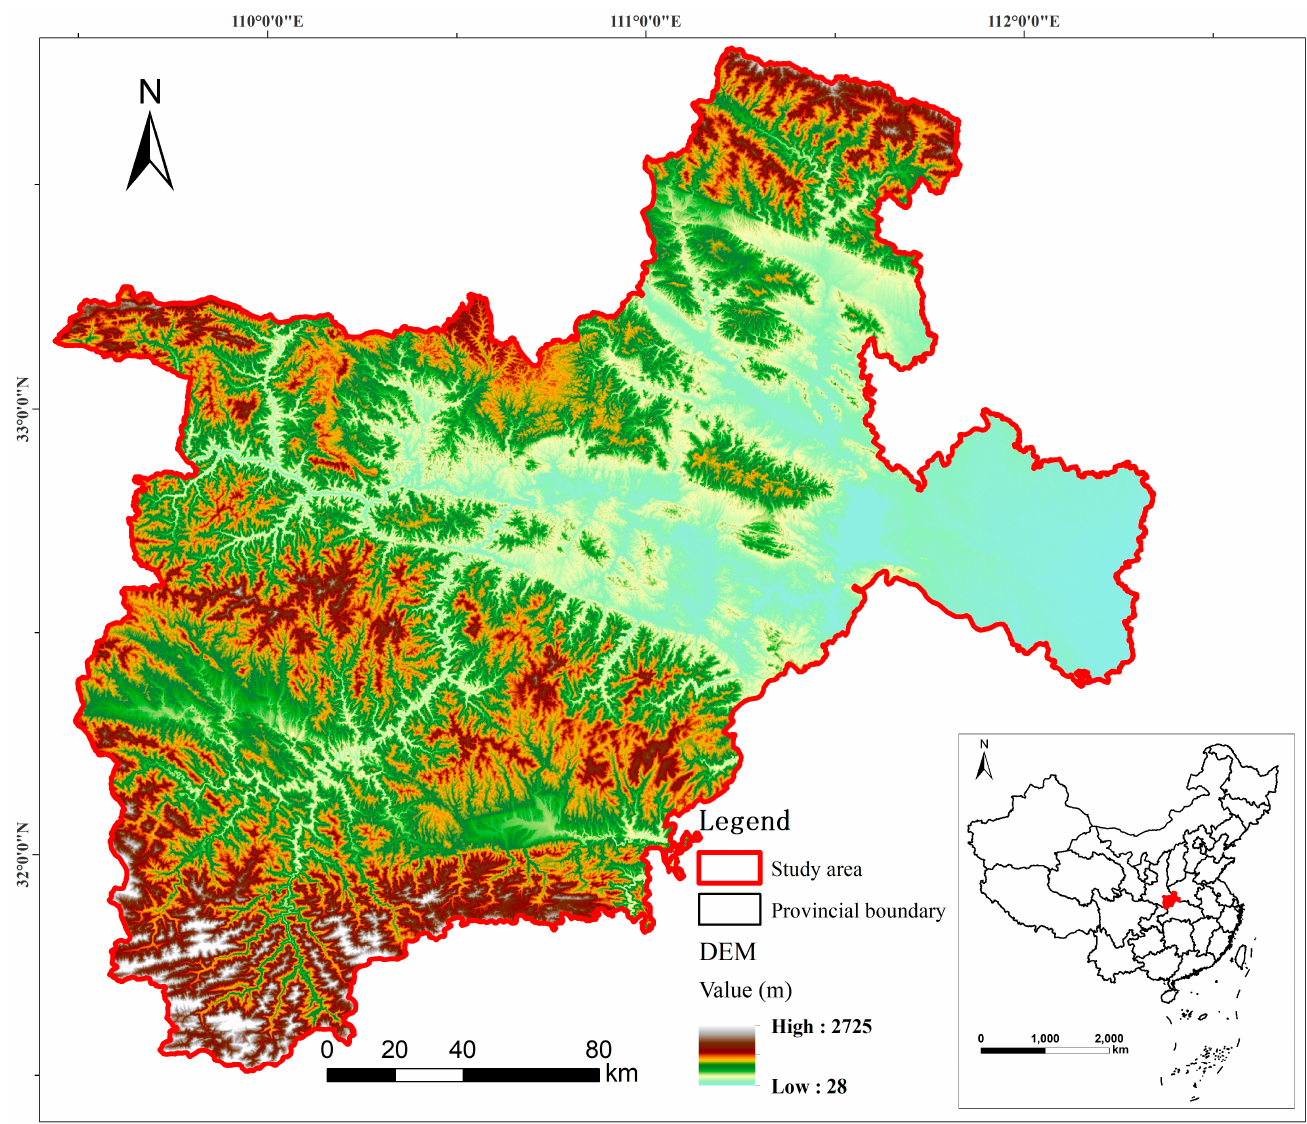
Figure 6. Location of the Danjiangkou Reservoir area, China.